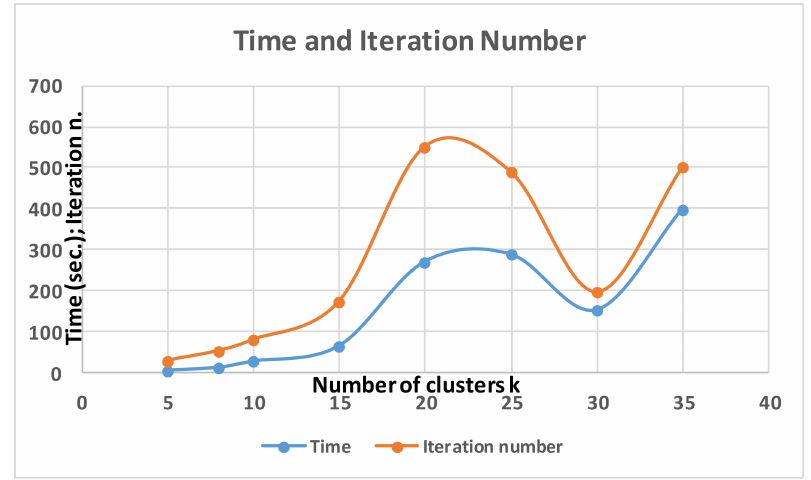
Figure A1. Time and iteration number versus the cluster number k (image processing of the same